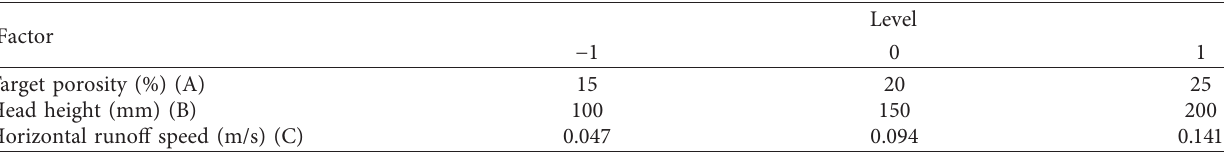
Figure 10: Normalized permeability coefficients after clogging for specimens of different porosities. Comprehensive analysis of PC clogging. Table 12: Design test factor level and number.